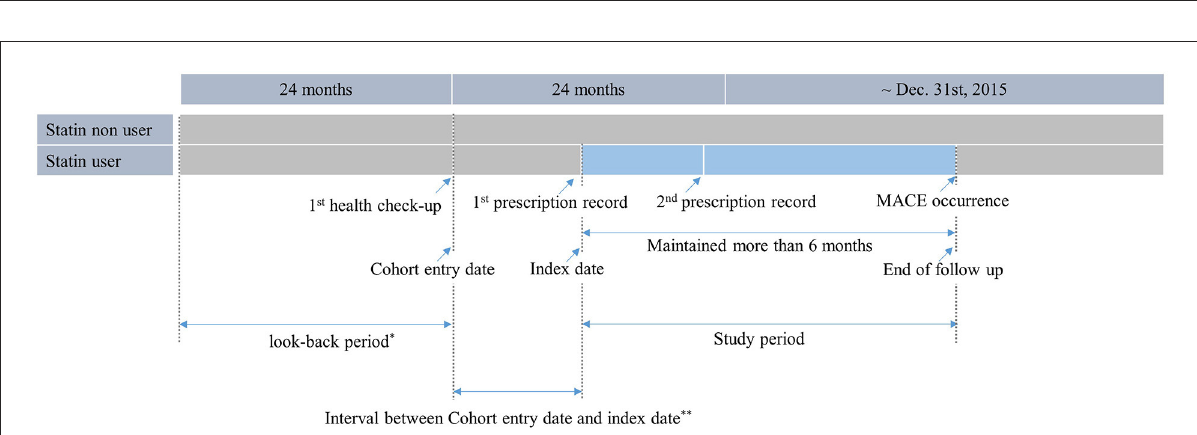
FIGURE2 Operational definition of statin users. Statin users were defined as those who received health check-up between 2009 and 2012, had a record of being prescribed statins at least twice within 2 years after the first health check-up, and were prescribed statins for more than 6 months.